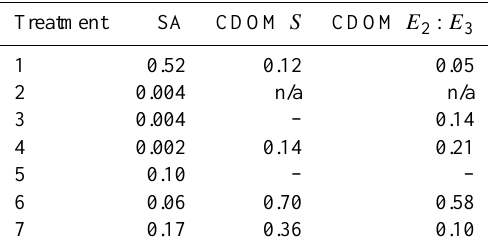
Table 3. Statistical evaluation of no effect of storage time ( p value). Tests were run separately for each treatment (as detailed in Table 1) and variable. For p < 0 . 05 time is considered to have a significant influence. Unmeasured data are shown as n/a; statistics that did not pass the quality control as “–”.